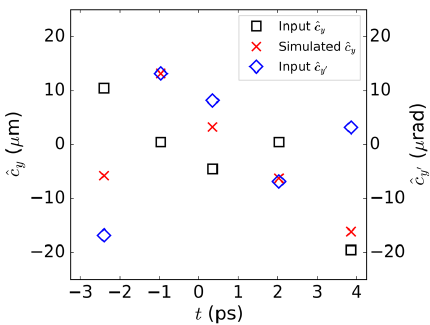
FIG. 5. Same as Fig. 4 but Q3 is used for